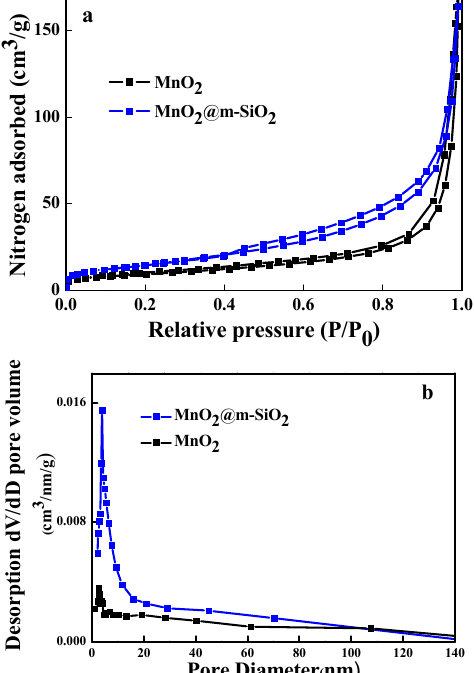
Figure 4. Nitrogen adsorption ( a ) and desorption ( b ) isotherms for MnO 2 and MnO 2 @m ‐ SiO 2 .